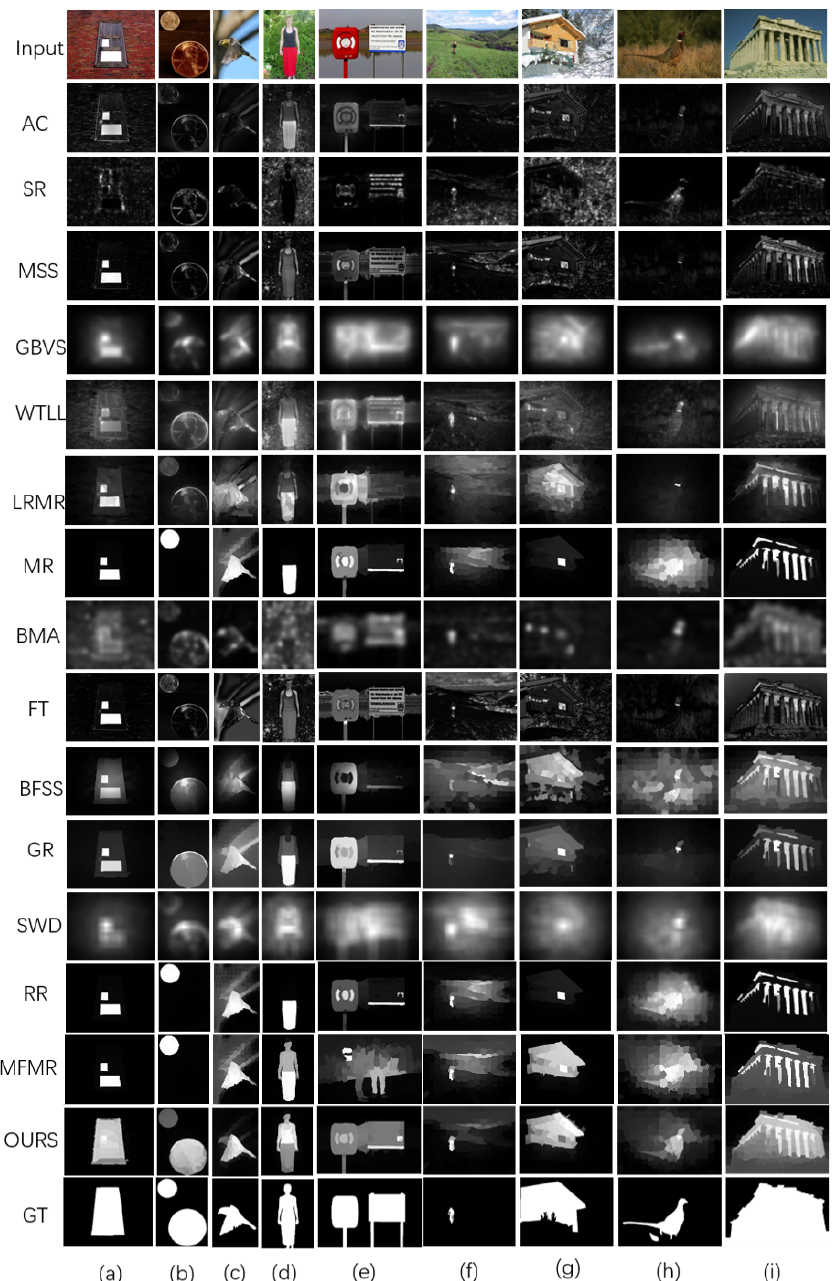
Figure 4. Visual comparisons of different methods on four datasets: ( a – c ) MSRA-5000 dataset; ( d , e ) ECSSD dataset; ( f , g ) SOD dataset; ( h , i ) DUT-OMRON